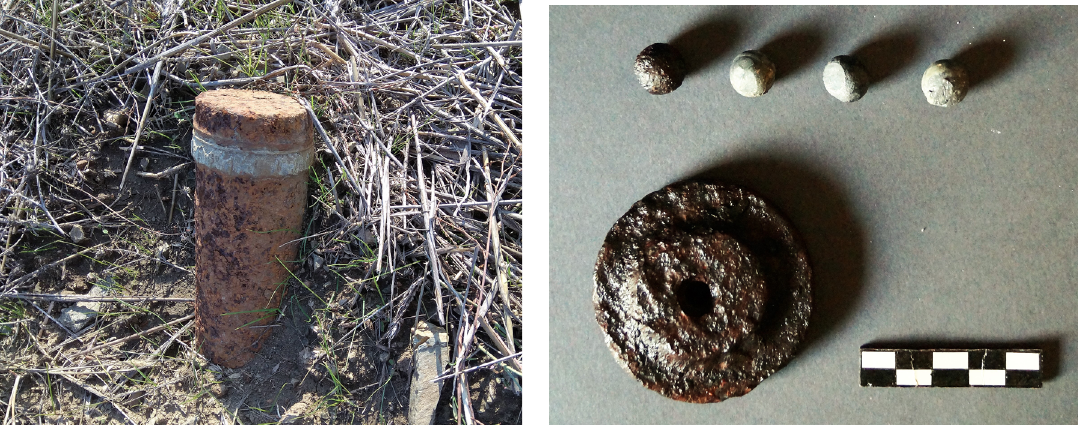
Figure 16. Military finds from the excavation (right) and the geophysical vey (left): lead and iron bullets and artillery shells (archive of the Ephorate of Antiquities at